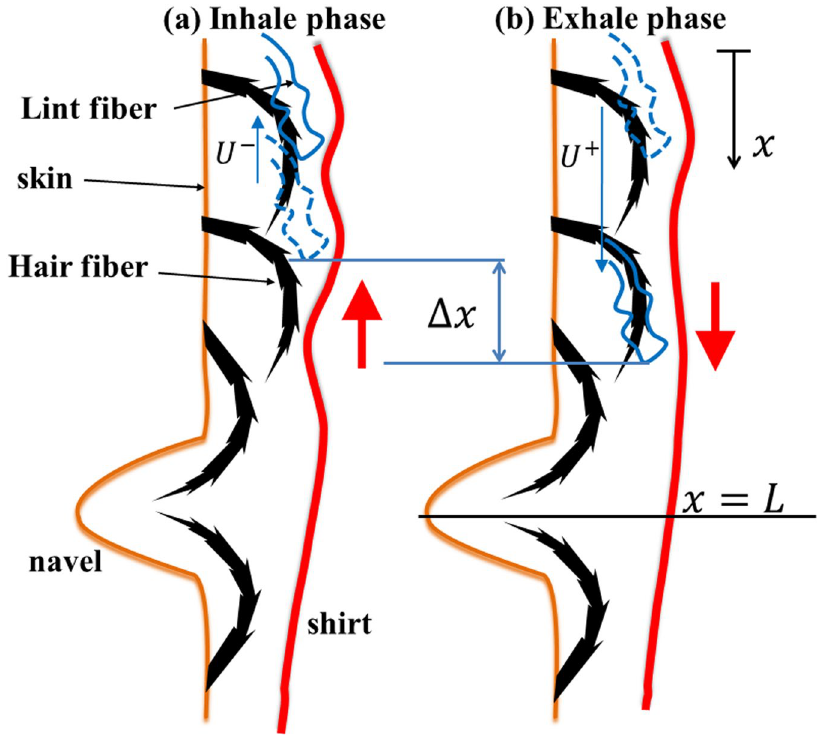
Figure 2. A cartoon illustrating the sliding motion of a lint fiber in an area superior to the navel. Two consecutive phases of a breathing cycle: ( a ) inhale, ( b ) exhale are shown. The spikes on the hair fibers represent the cuticle scale edges. The net effect of the relative oscillatory motion of the fabric, as shown by the red arrow, is to transport the lint fiber toward the navel in a cycle because the hairs point toward the navel. The final (initial, respectively) location of the lint in each phase is shown by the solid (dashed) curve. Since the frictional force will be more in the tip-to-root direction the sliding velocity of the lint fiber in the exhale phase (shown by the blue arrow) is less in the inhale phase than it is in the exhale phase. ∆ x denotes the net displacement of the lint fiber in a